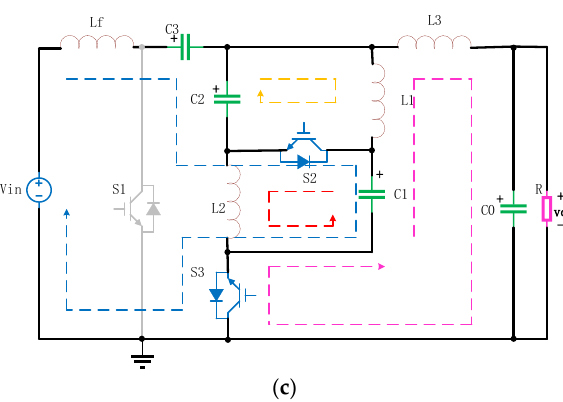
Figure 3. Equivalent circuits of the CUK-based ZSI in Figure 3 in one switching period ( a ) S1 and S3 are ON, S2 is OFF; ( b ) S1and S2 are ON, S3 is OFF; ( c ) S2 and S3 are ON, S1 is OFF.